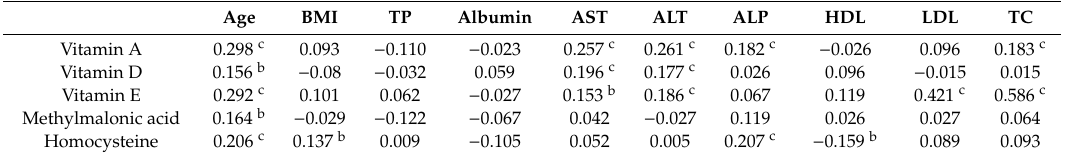
Table 5. Correlations among vitamin status, basal characteristics, and biochemical parameters of the study population a